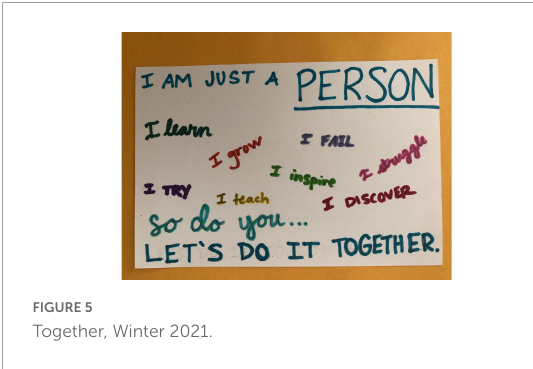
FIGURE4 Deer in the headlights, Fall 2020.